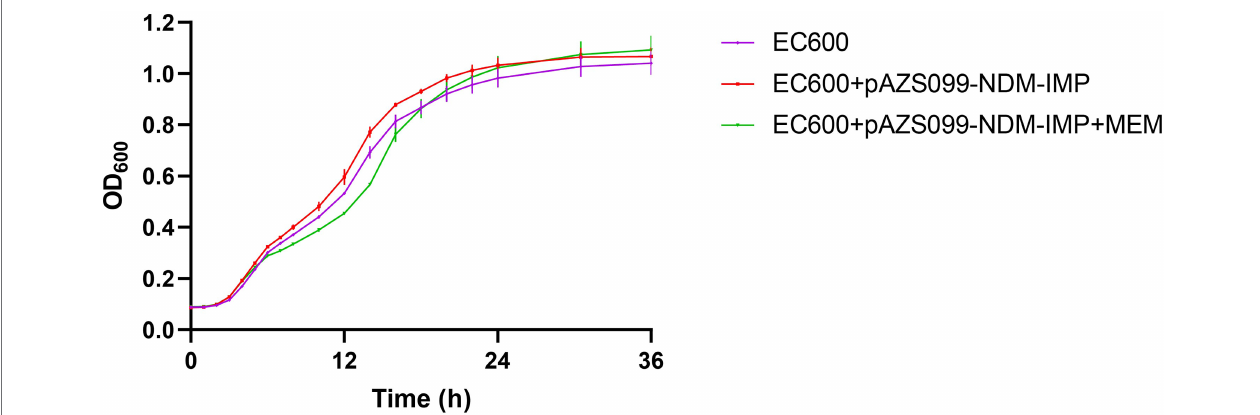
FIGURE 4 | Growth curve comparison. Growth curves of recipient strain E. coli EC600 and the transconjugants harboring bla NDM-1 and bla IMP-4 plasmid pAZS099- NDM-IMP with and without meropenem (value of p >0.05). EC600 means the recipient strain E. coli EC600. EC600 + pAZS099-NDM-IMP means the transconjugant harboring bla NDM-1 and bla IMP-4 plasmid pAZS099-NDM-IMP in antibiotic-free LB broth. EC600 + pAZS099-NDM-IMP+MEM means the transconjugant harboring bla NDM-1 and bla IMP-4 plasmid pAZS099-NDM-IMP in LB agar plates containing